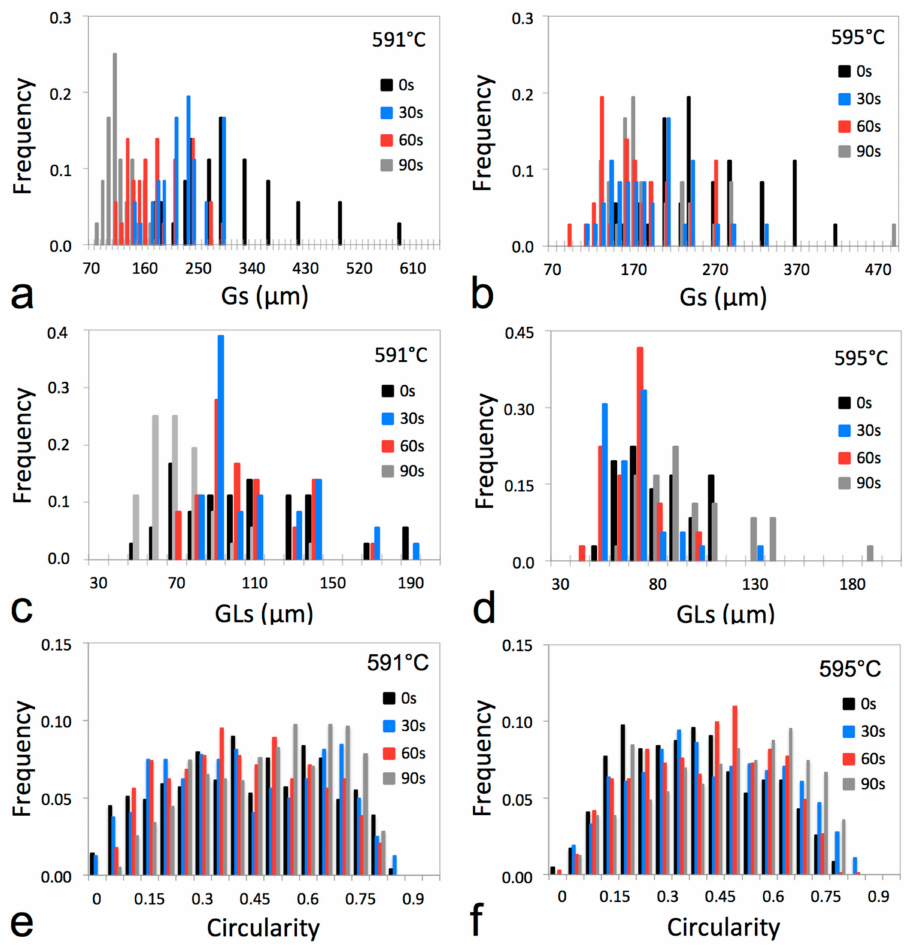
Figure 13. Distributions of B319+Fe alloy grain size ( a , b ), globule size ( c , d ) and circularity ( e , f ) measured after isothermal heat treatment (at 591 ◦ C and 595 ◦ C, respectively) for 0, 30, 60, and 90